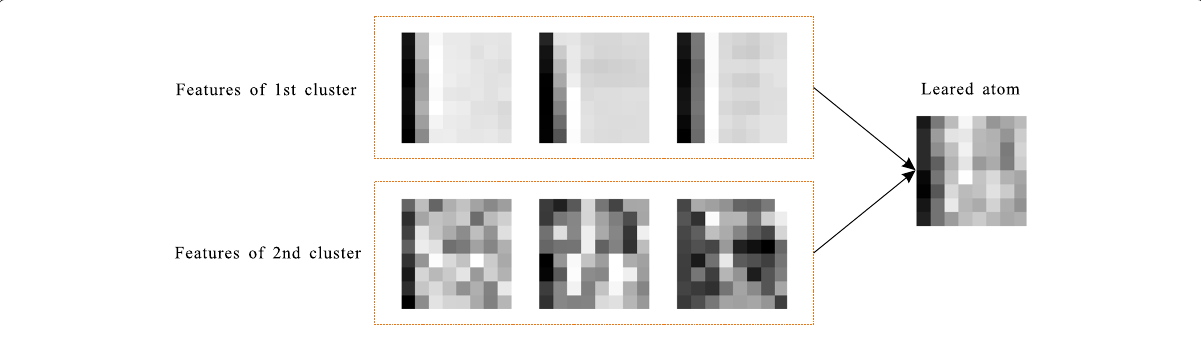
Fig. 3 Part of the features invoked the 12th atom and the learned atom